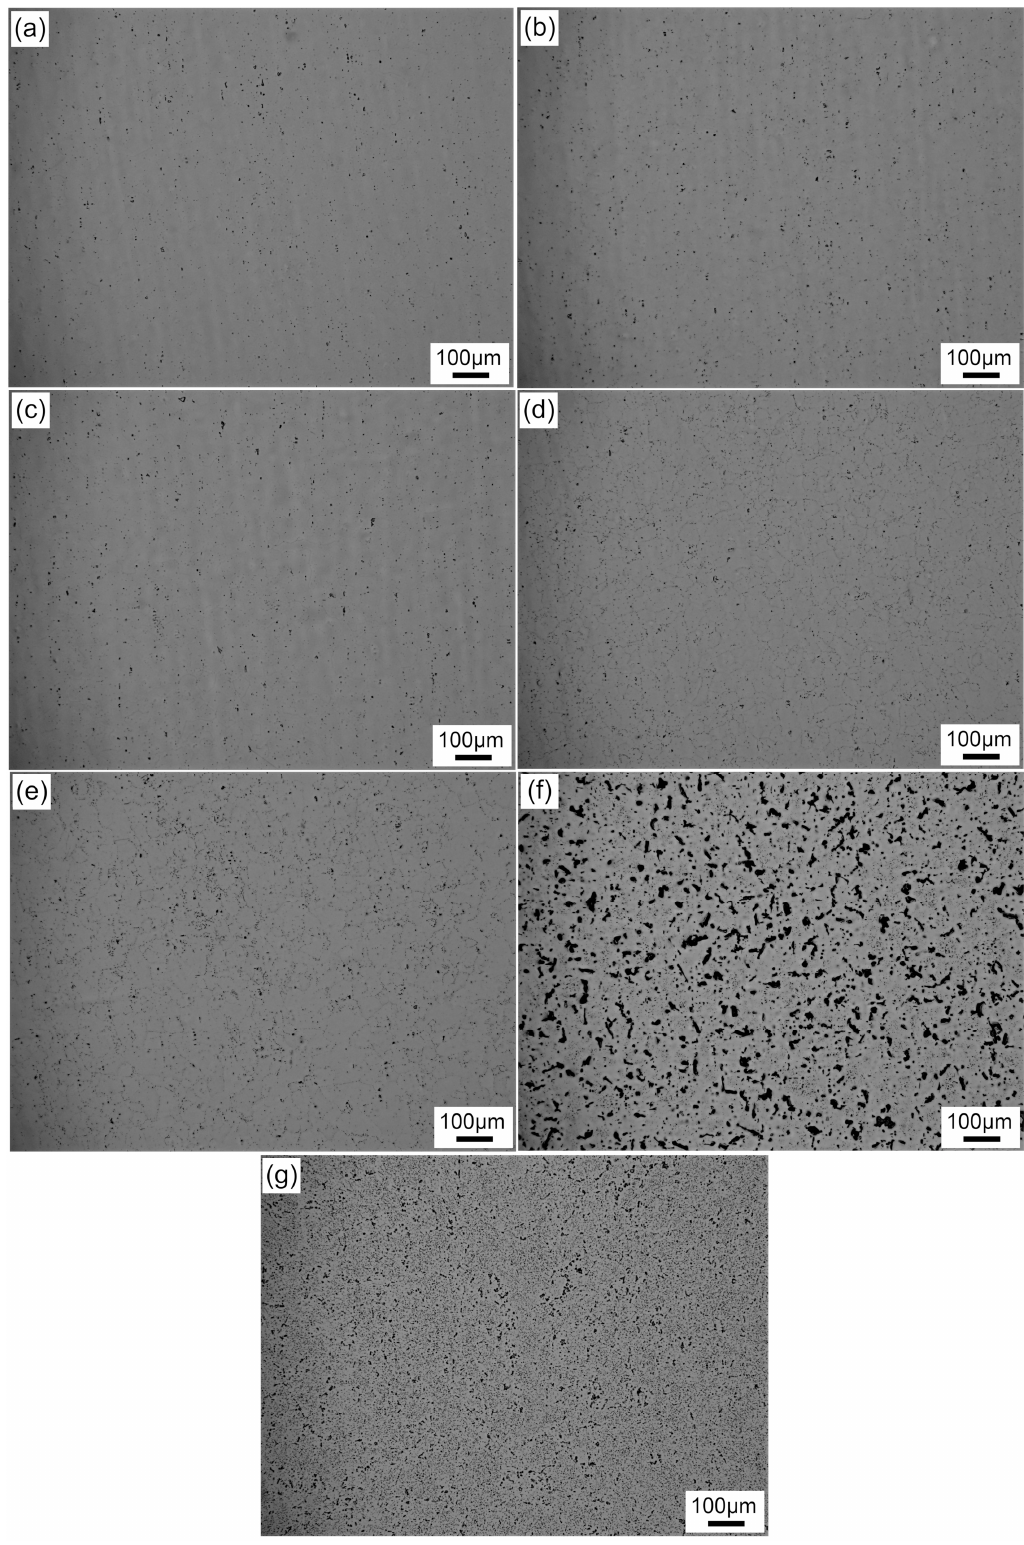
Figure 3. Microstructures of samples with the different quenching rates or annealing treatment at 400 °C for 2 h after pre-aging treatment: ( a ) 58.9 °C/s, ( b ) 14.0 °C/s, ( c ) 7.0 °C/s, ( d ) 2.8 °C/s, ( e ) 1.6 °C/s, ( f ) 0.01 °C/s, and ( g ) annealing at 400 °C for 2 h after water quenching.